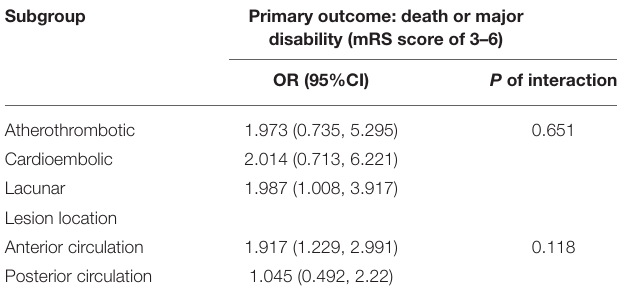
Table 2 unless the variable was used as a subgroup variable. NIHSS indicates National Institutes of Health Stroke Scale; and OR, odds ratio.